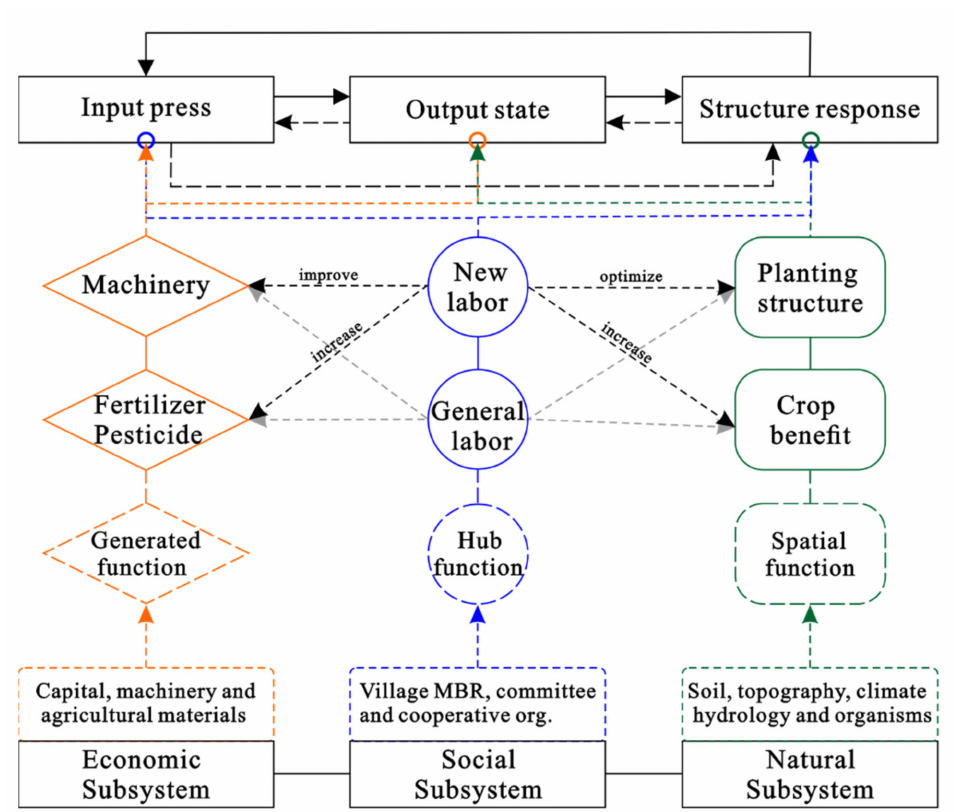
Figure 10. Logistics of the village cultivated land use intensification (VCLUI) based on the pressure– state–response (PSR)